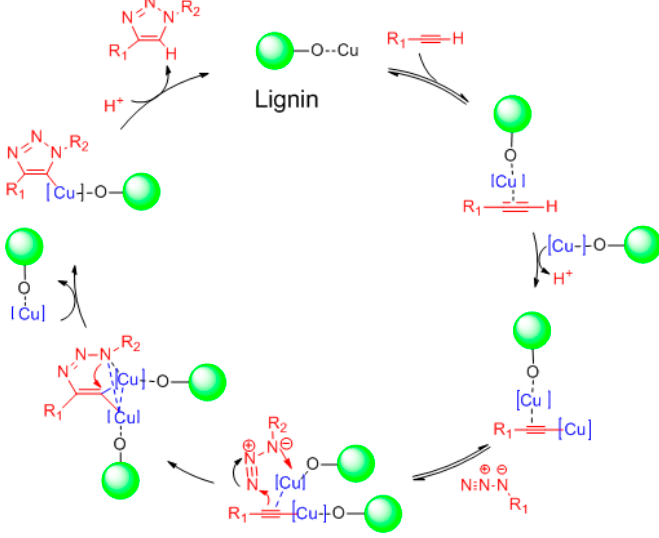
Table 2. The brief comparison of this catalyst with previous ones for Huisgen “click” reactions of azides and